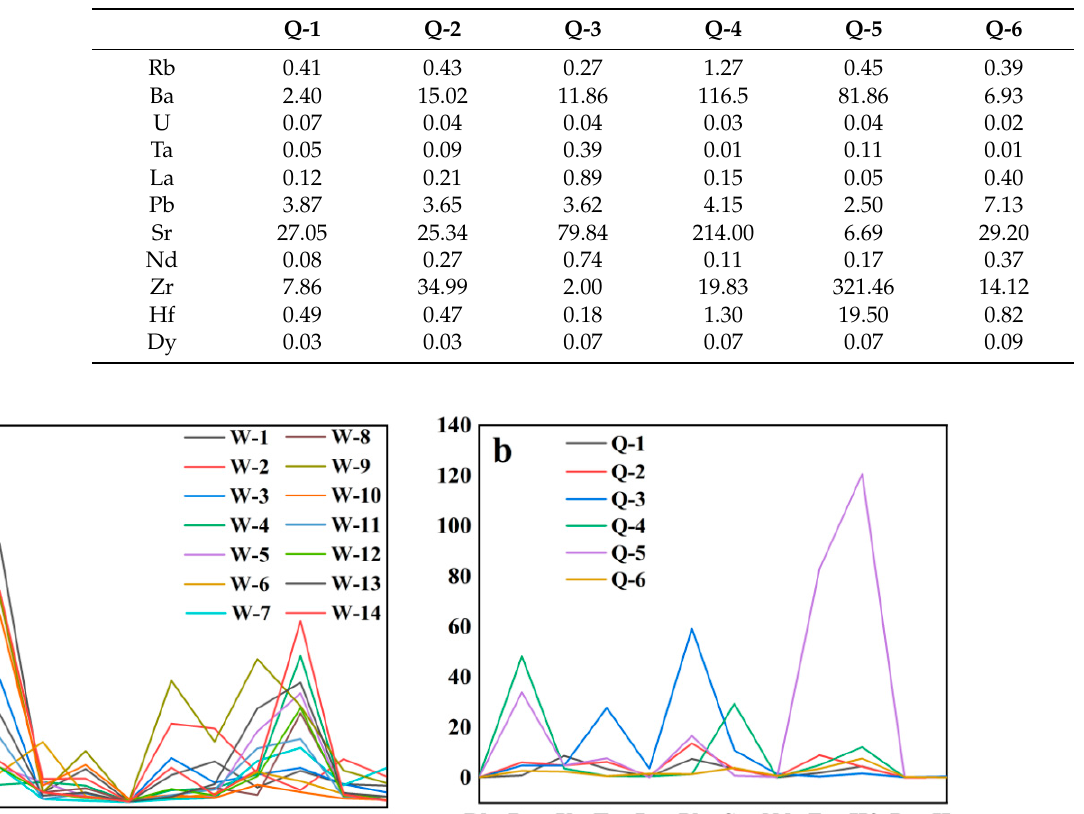
Table 4. Qing dynasty jadeite trace elements (ppm).